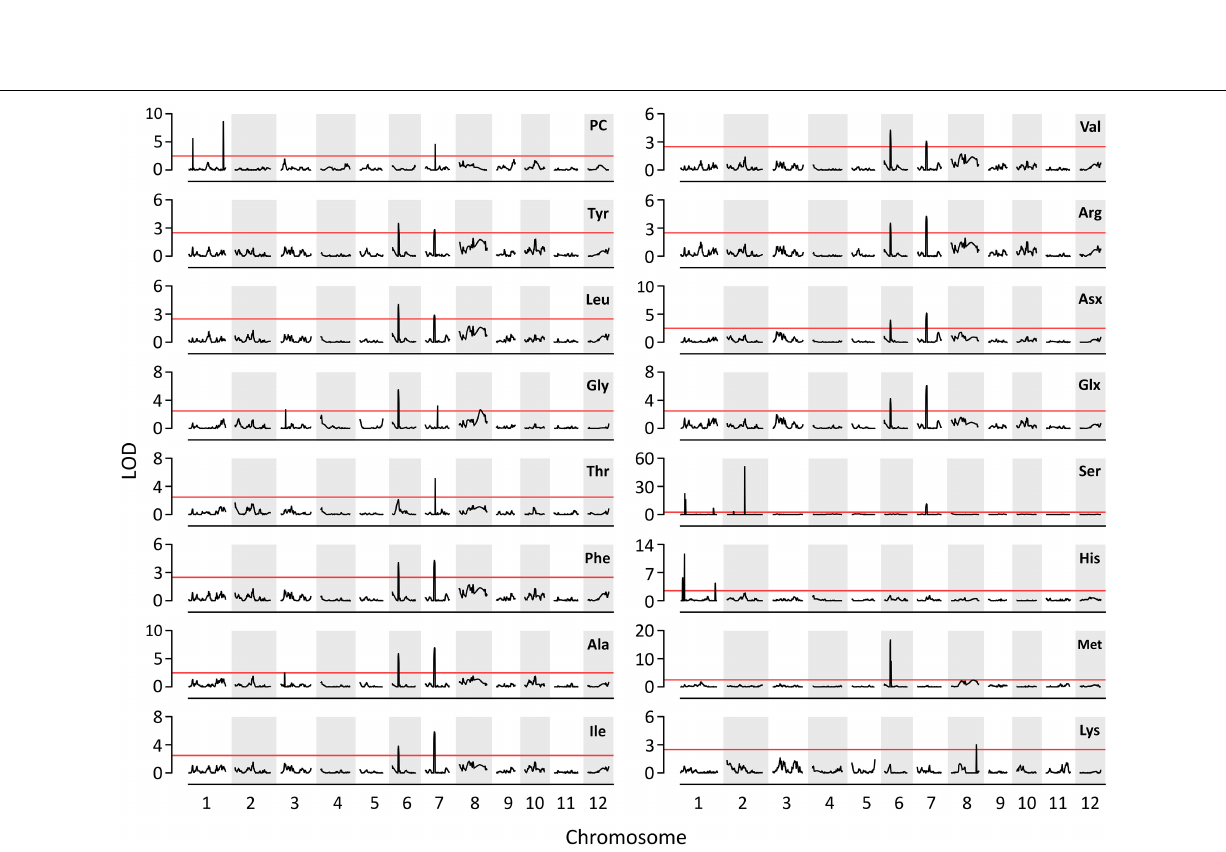
Frontiers in Genetics |